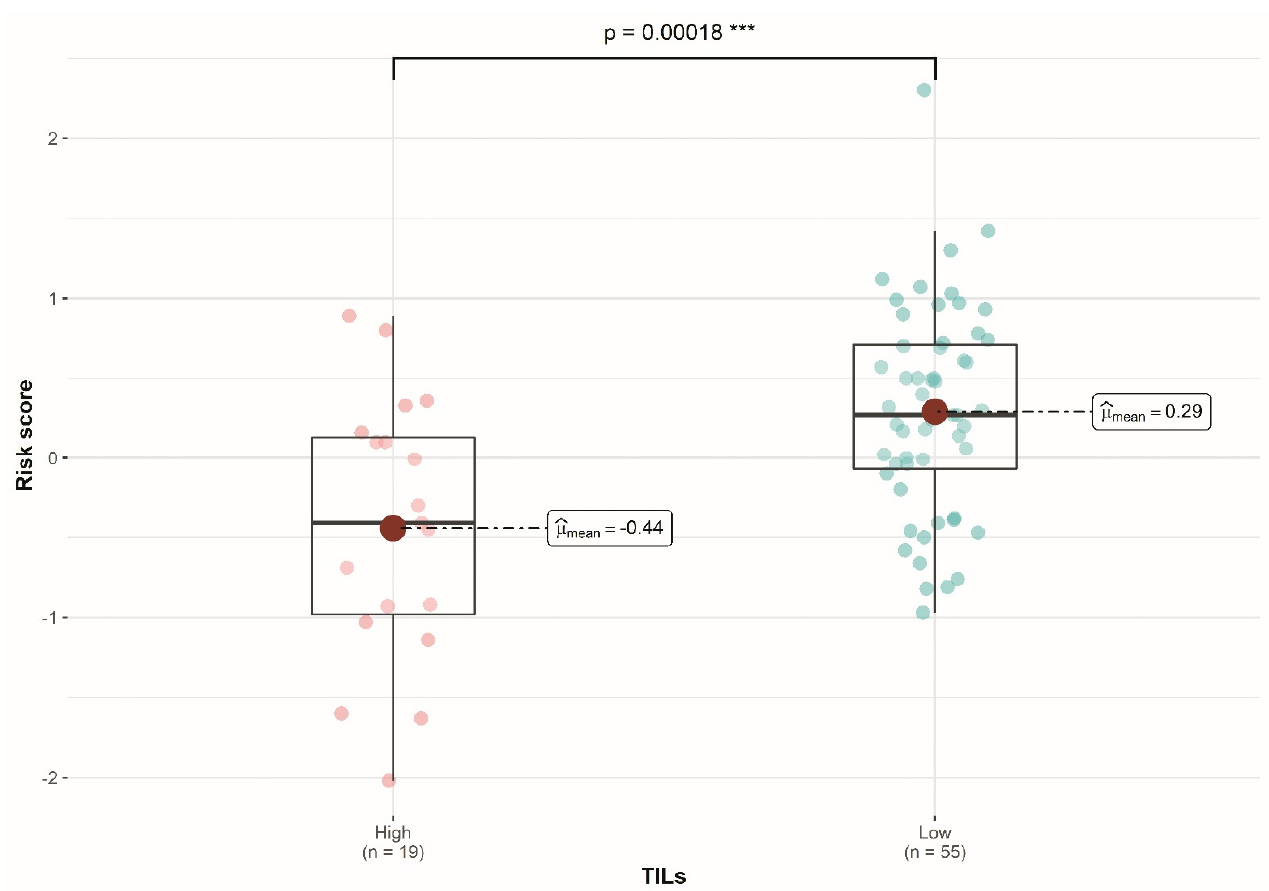
Figure 4. Three genes signature as prognostic factor of DRFS in TNBC subtypes. The 3 genes-score was statistically significant in the immunomodulatory and mesenchymal stem-like subtypes. A high-risk score was shown in patients with low TILs. Differences between groups were statistically significant ( p < 0.001) (Figure 5).